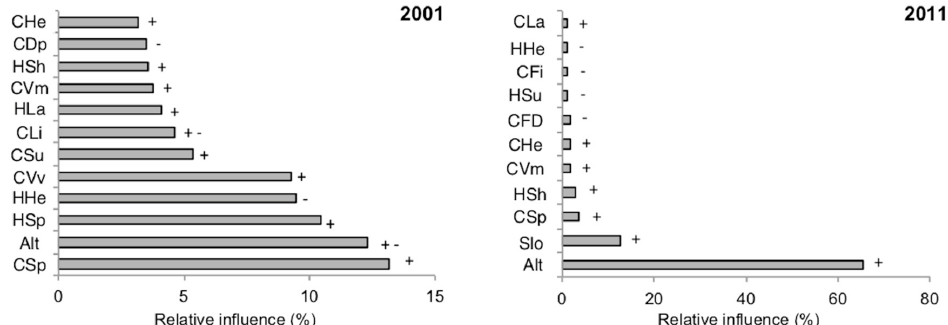
Figure 4. Relative influence of quantitative variables in a BRT model for capercaillie summer occurrence in 2001 and 2011. Signs indicate whether the relationship was negative ( − ) or positive (+) monotonic or non-monotonic (+ − ). Explanatory variables, with their codes, are reported in Table 2. Overall, only a limited number of explanatory variables had a relative influence ≥ 10% (Figure 5). Among these, for both years, altitude was a fundamental environmental factor. More specifically, in 2001, capercaillie was most commonly found at altitudes from 1570 to 1670 m a.s.l. with a decreasing trend at altitudes higher than 1670–1700 m a.s.l. On the contrary, the species had clearly moved to higher altitudes in 2011, ranging from 1620 to 1750 m a.s.l., with this factor being extremely important compared to other explanatory variables for the species (i.e., 65.3% of relative influence). Furthermore, there was no negative trend in presence of the species for higher altitudes.